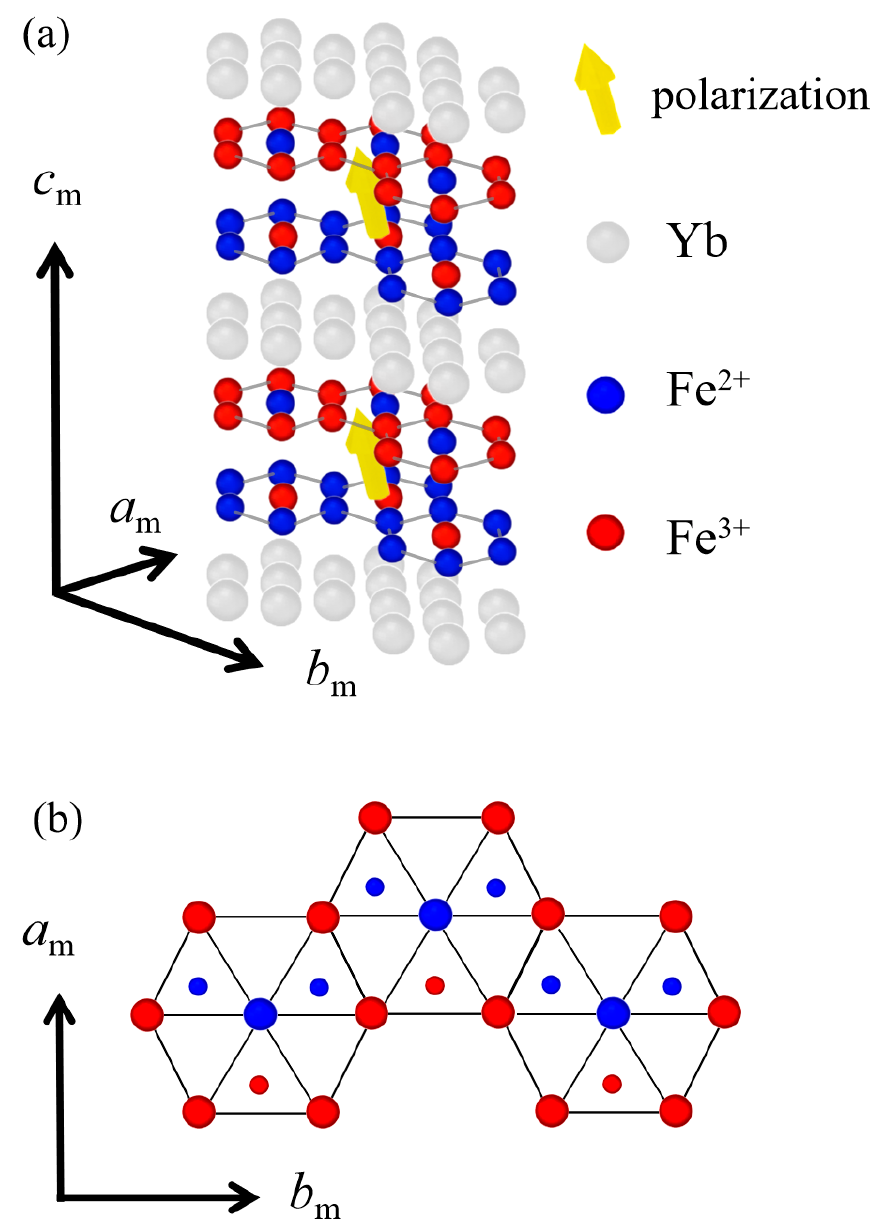
Figure 1. ( a ) Crystal structure of YbFe 2 O 4 after Ref. [9]. Oxygens are not depicted for clarity. The yellow arrows denote the polarization direction. ( b ) Schematic view of the W -layer in a plane perpendicular to the c m axis. Red and blue circles denote Fe 3+ and Fe 2+ , respectively and small ones Fe 3+ and Fe 2+ in the lower layer.